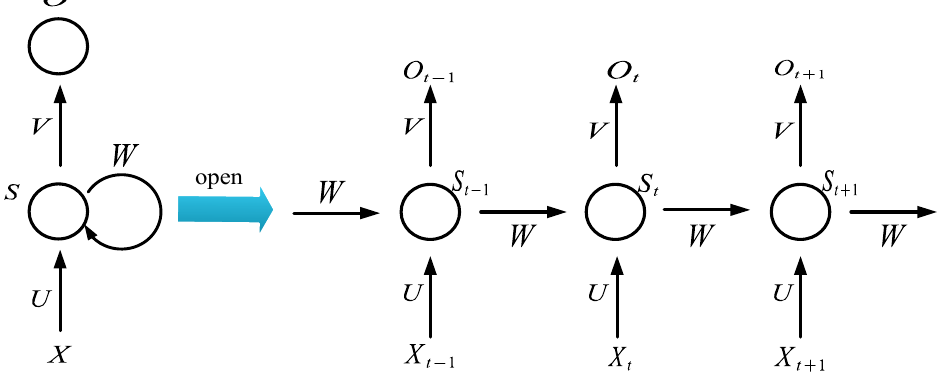
Figure 1. Structure diagram of RNN neural network.